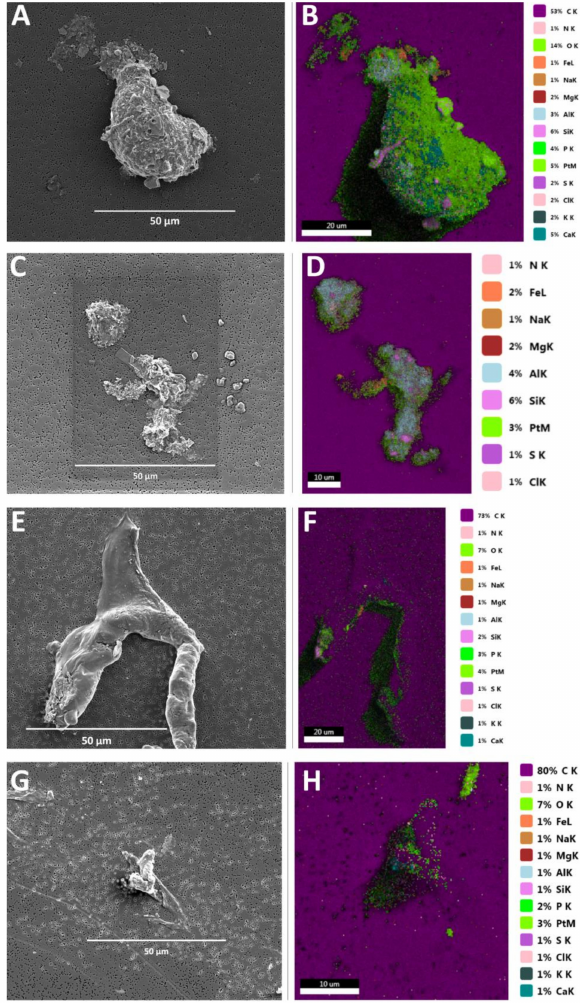
Figure 6. Scanning electron microscope images of an aggregates, created within the intake water ( A , C ) and corresponding energy dispersive X-ray (EDX) spectroscopic analysis ( B , D ). Aggregates formed within the RO feed tank water ( E , G ), alongside the EDX spectroscopic analysis of the protobiofilm ( F , H ). Three eukaryotic taxa were detected in the aggregates formed in the SWRO feed tank water: Archaeplastida, Opisthokonta, and SAR. The supergroup of Opisthokonta dominated the community (92.6%), followed by Archaeplastida (5.8%) (Figure 3B). Pielou’s evenness indicates that OTU abundances within the aggregate sample were highly diverse (Table 1). From the intake seawater aggregates, the no 18S rRNA region was amplified, due to low levels of rDNA